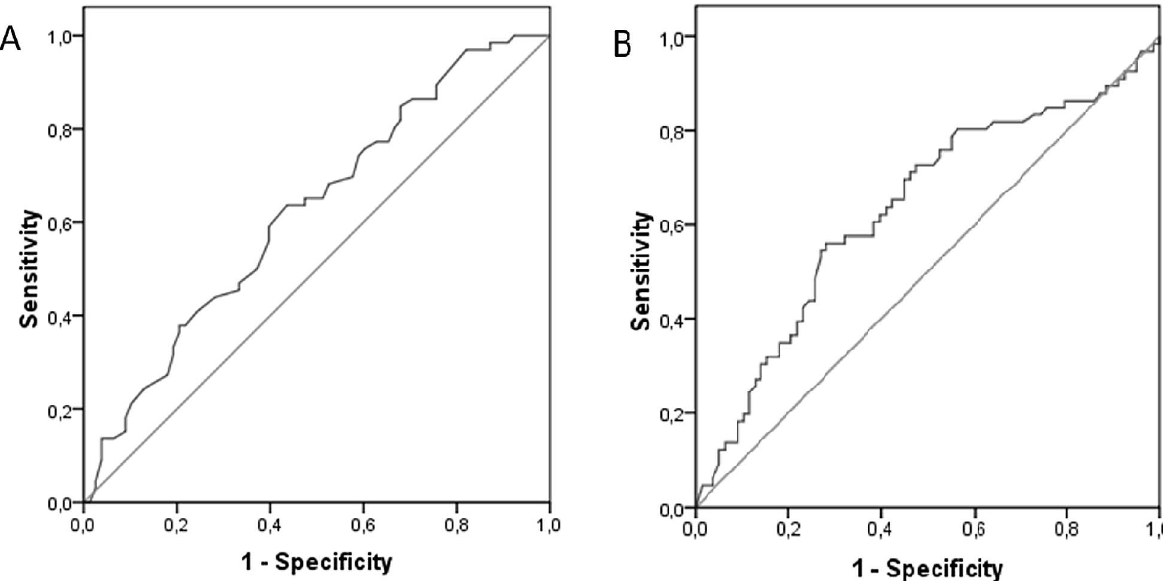
Fig 1. ROC curvesfor the predictionof idiopathic recurrentmiscarriage basedon estradiol and AMH levels. (A) Estradiol level. (B) AMH